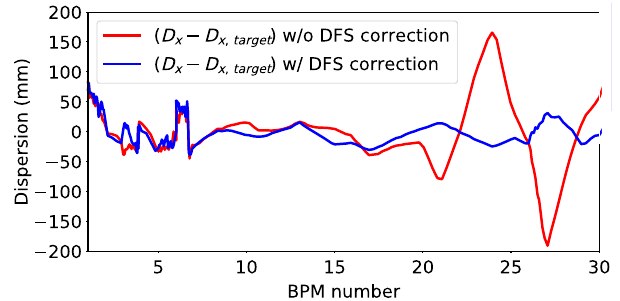
FIG. 6. Norm of the difference ( μ m) between the vertical orbit at high intensity, 6 . 0 × 10 9 electrons (y HQ ) and at low intensity, FIG. 4. Difference between the measured horizontal dispersion 2 . 0 × 10 9 electrons, (y ( D x ) and the target dispersion ( D x; ) vs BPM number before LQ ) vs the number of iterations of the WFS target (red) and after (blue) applying DFS correction.